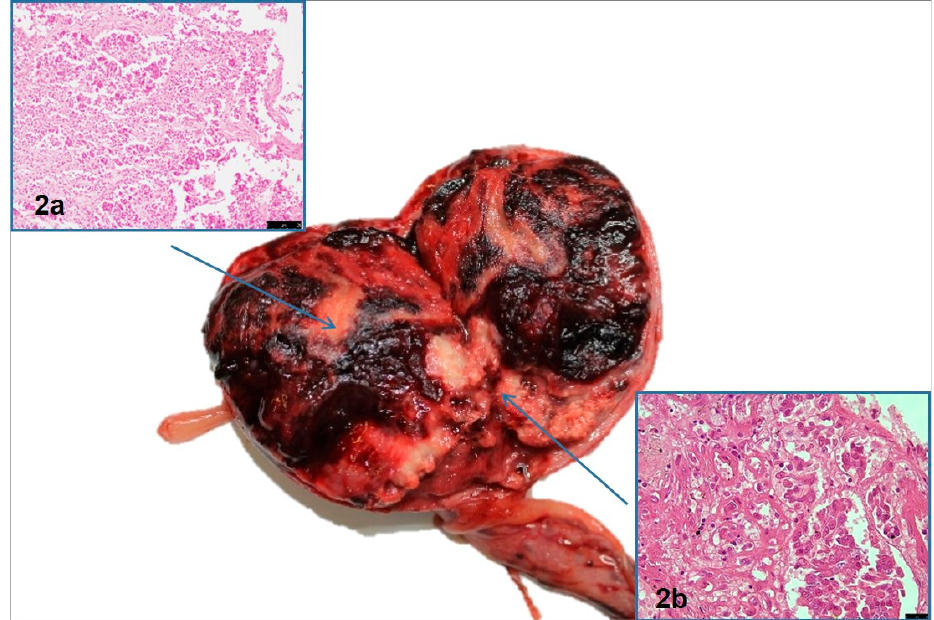
Figure 2. The left gonad mass (5 × 4 × 3 cm), On the cut section, a variegated appearance can be observed, characterized by pseudo-lobular patterns with double neoplastic components. ( a ) Inter- stitial cell tumor, HE (20×), scale bar: 25 μ m; ( b ) sustentacular tumor, HE (40×), scale bar: 25 μ